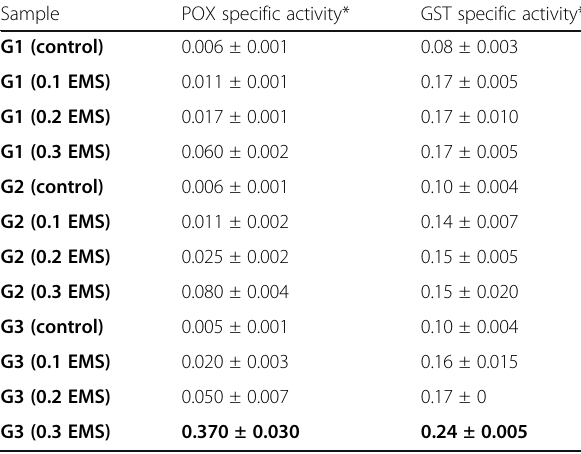
Table 8 Changes in peroxidase (POX) and glutathione S - transferase (GST) activities of three lentil cultivars using three doses of ethyl methane sulfonate (0.1, 0.2, and 0.3%)